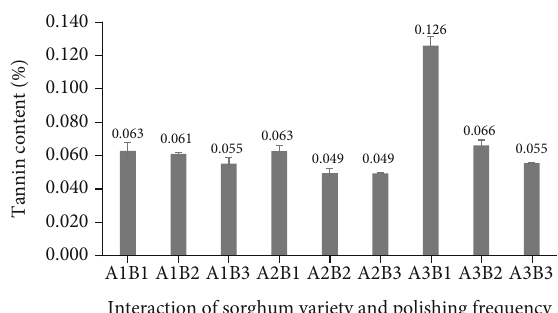
Figure 1: Tannin content of three varieties of sorghum grain processed with di ff erent polishing